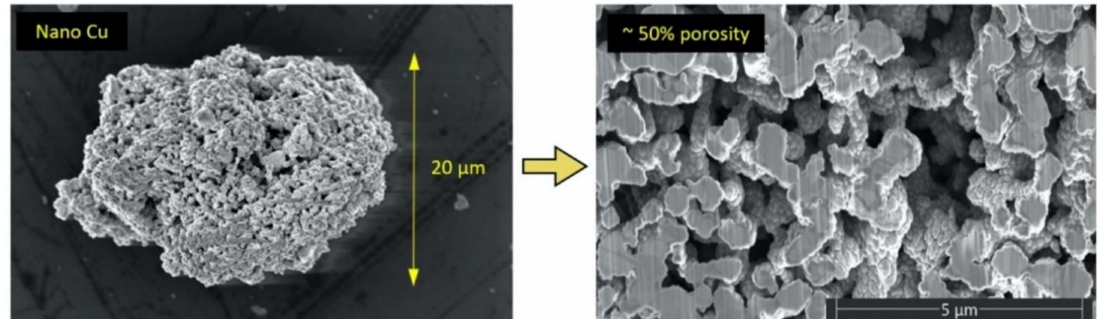
Figure 5. Micrograph of spray-dried Cu powder illustrating particle porosity. Very small particles are also found to be bound with one another on the right-most micrograph of the powder. These observations attest to the nanostructure associated with the spray-dried Cu